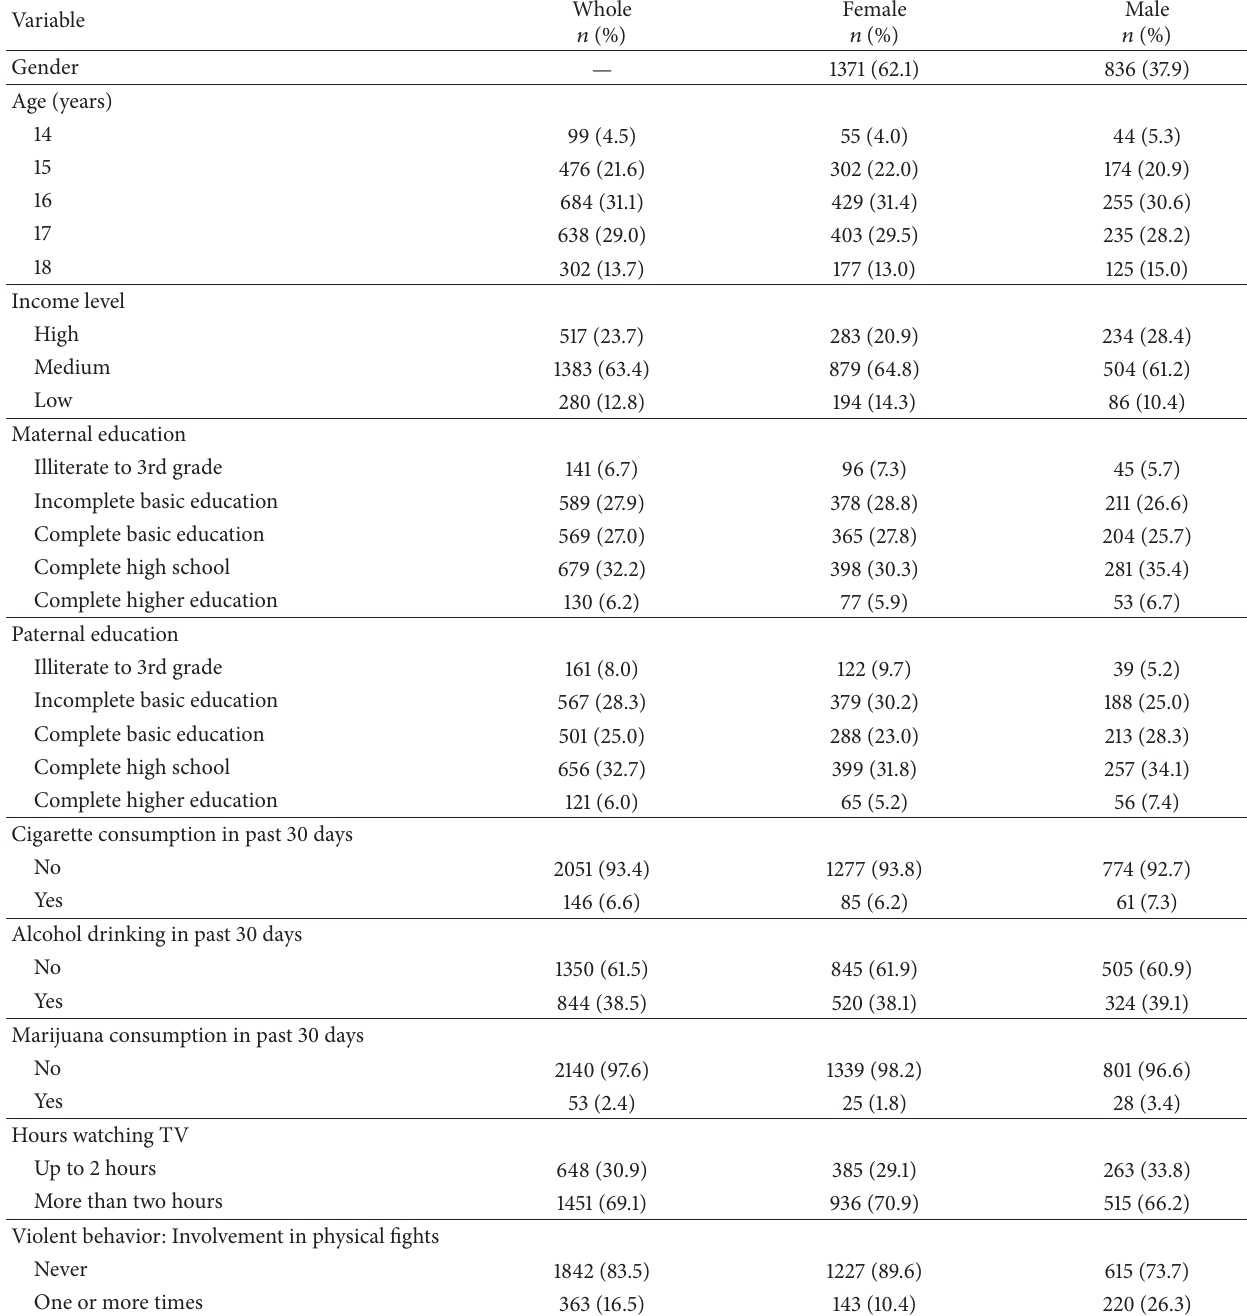
Table 1: Socio-demographic characteristics and prevalence of violent behavior/physical fights among adolescents, State of Sergipe, Brazil, 𝑛 =